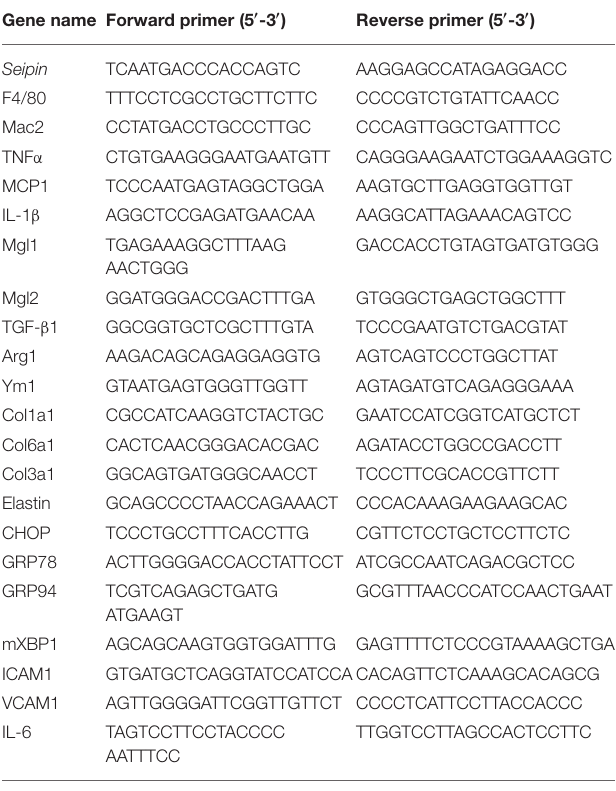
TABLE 1 | Primer list for quantitative real-time